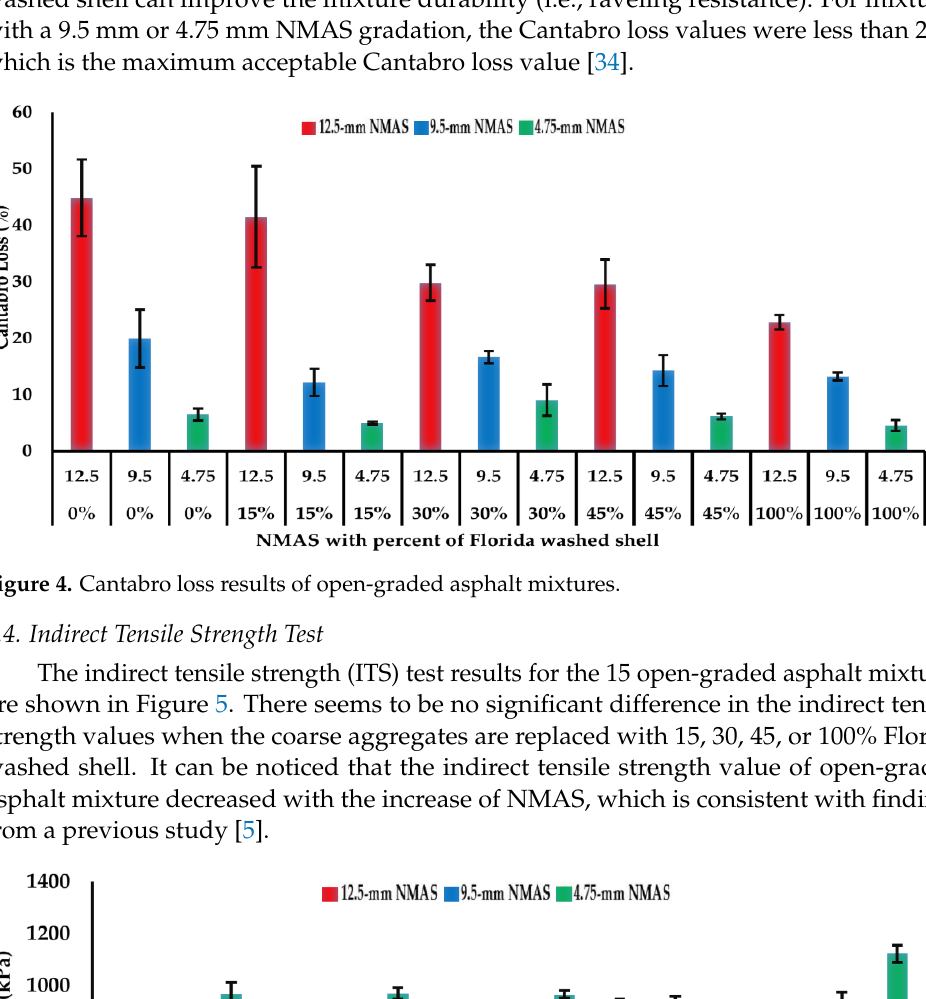
Table 3. Air void content of open-graded asphalt mixtures. Type of Mixture